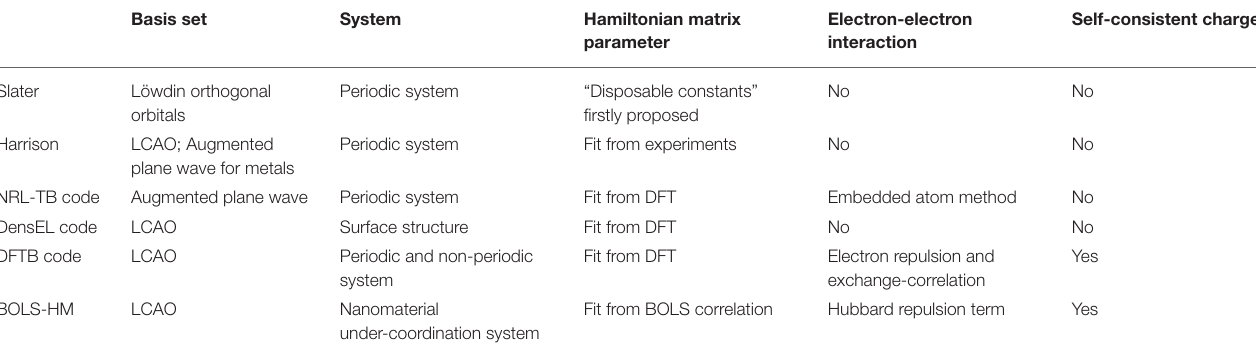
TABLE 1 | Comparison of current TB methods with